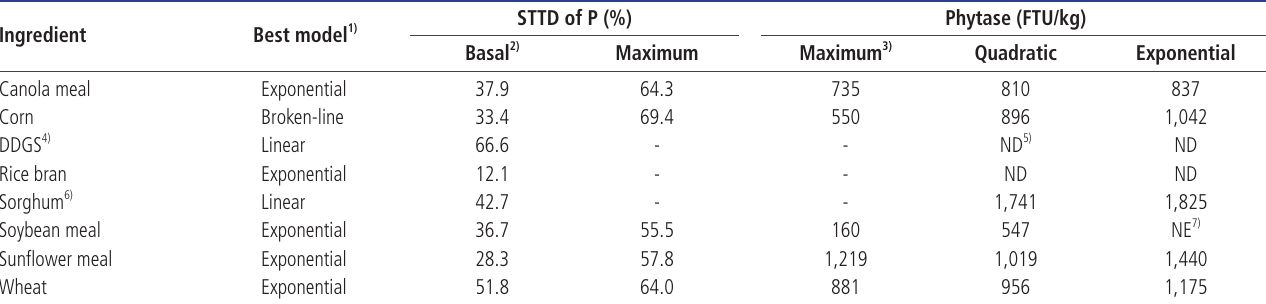
Table 5. Phytase concentration needed to maximize the standardized total tract digestibility (STTD) of P in various feed ingredients determined by best goodness of fit regressions, and the first intercept of quadratic and exponential models with the plateau of the broken-line model Ingredient